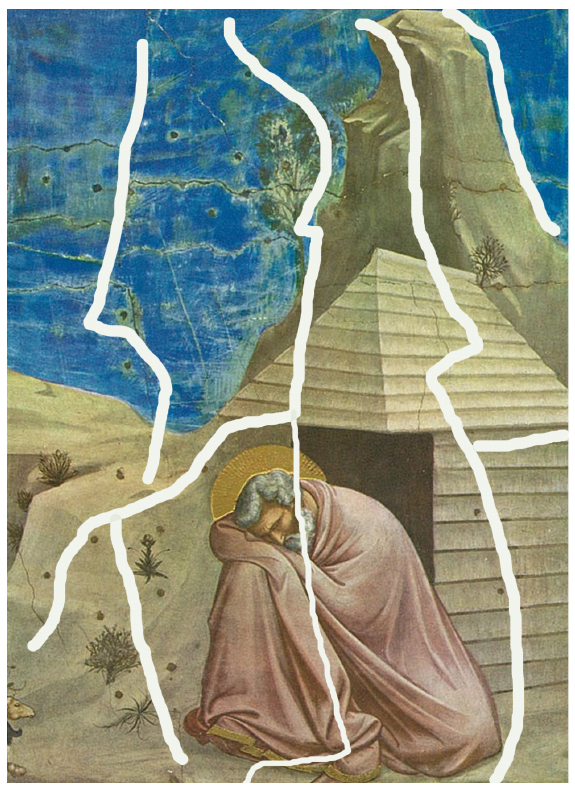
FIGURE 5 | ‘Joachim’s dream’ (detail) by Giotto,